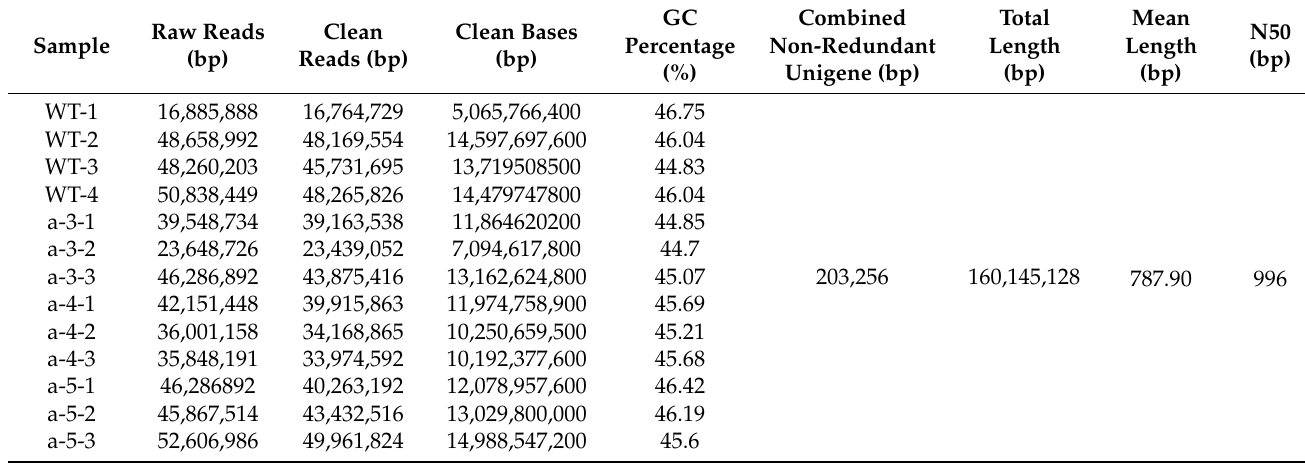
Table 1. Summary of assembly and annotation of the transcriptome.